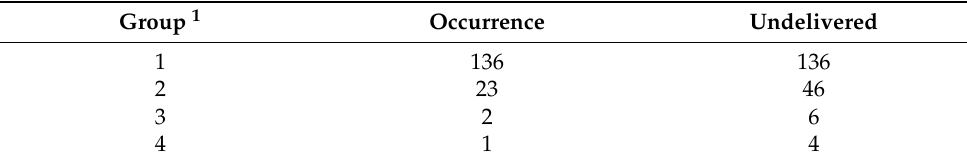
Table 1. Numbers of consecutive undelivered messages broken down by